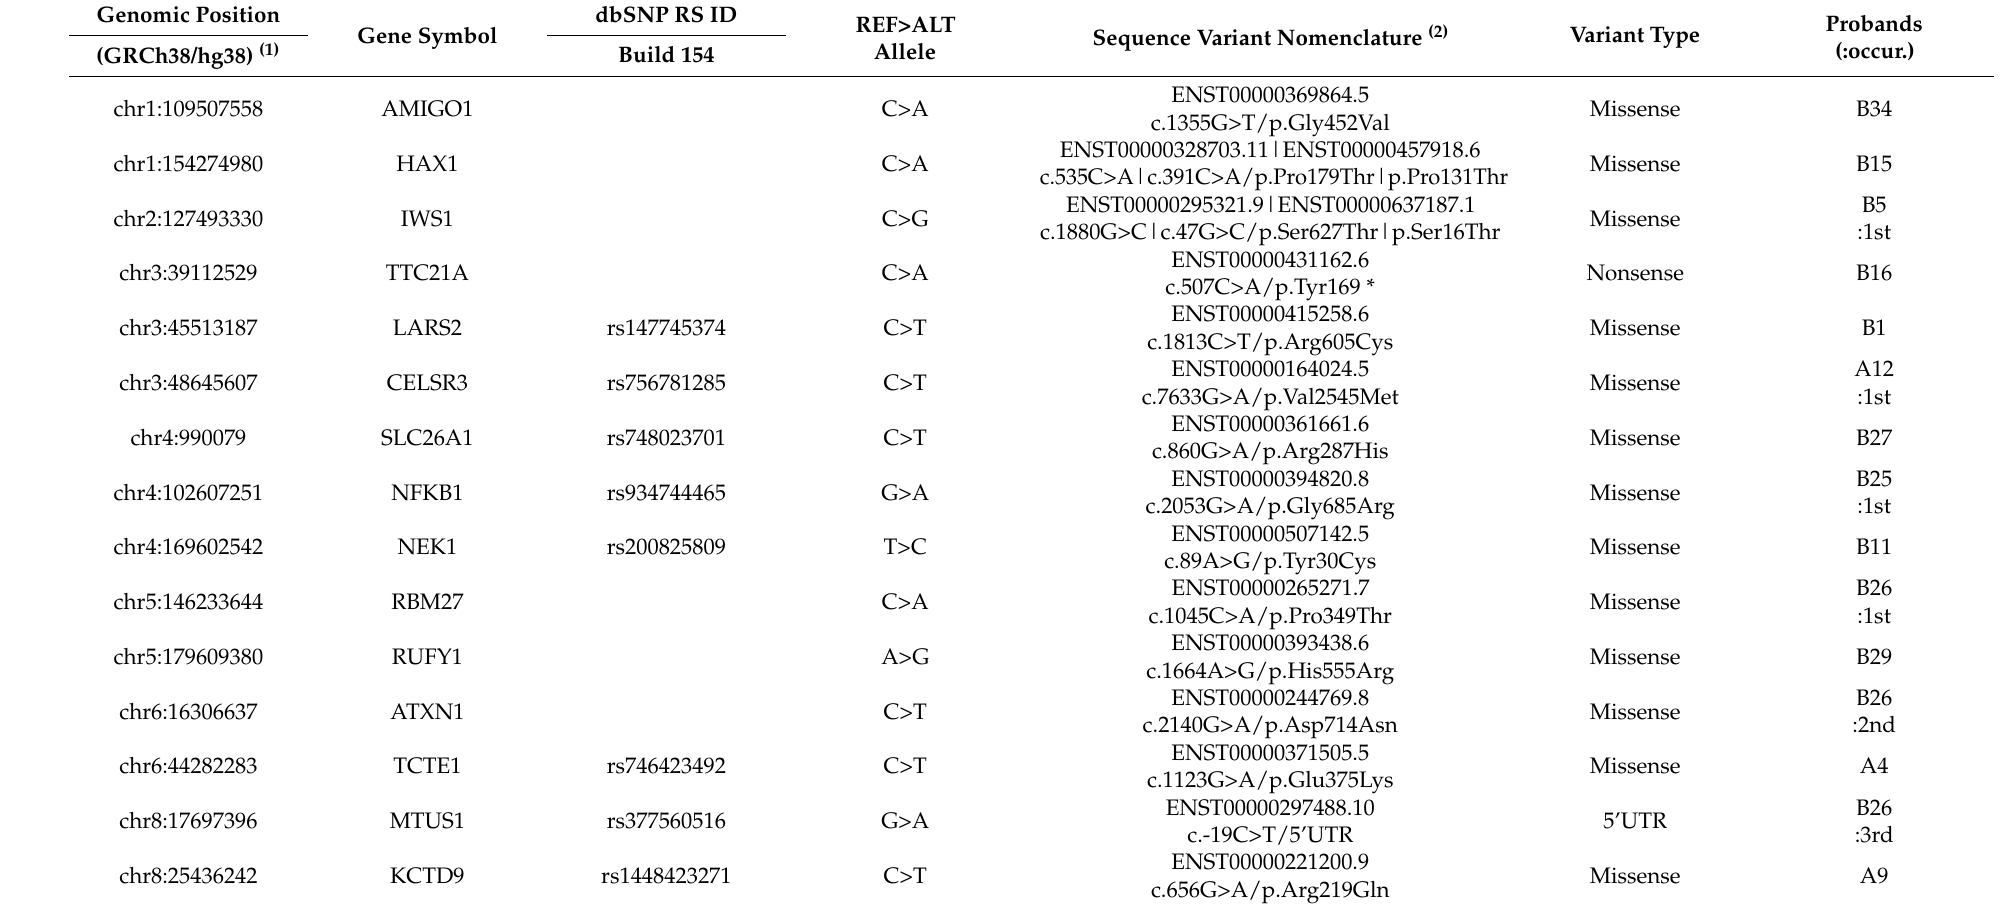
Table 2. De novo mutations observed in 51 Korean ASD